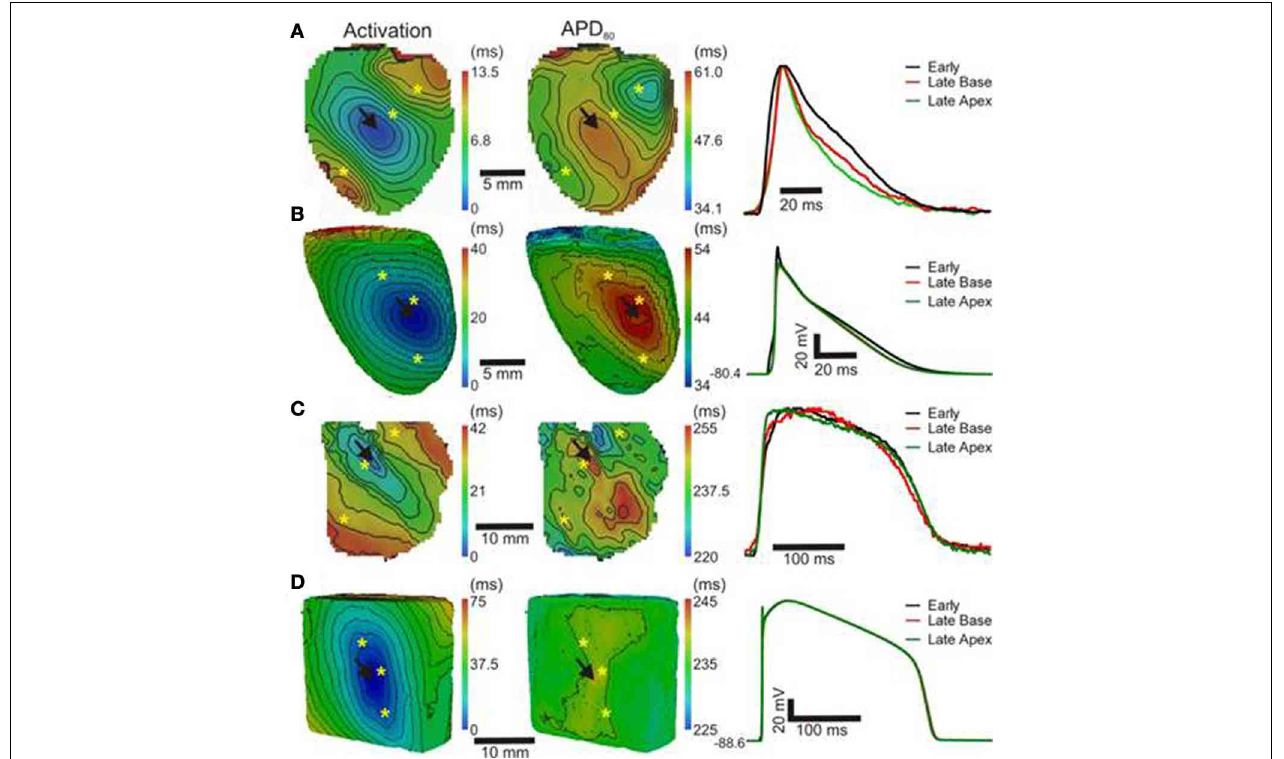
FIGURE 2 | APD distributions for alternative activation sequences in rat and pig myocardium. Rat experiments (A) and simulations (B) ; and pig experiments (C) and simulations (D) with pacing from the mid free left